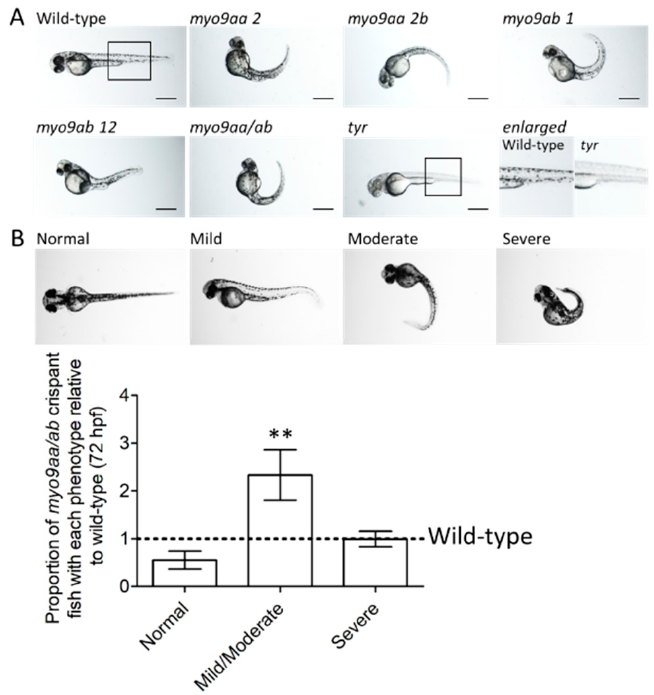
Figure 1. Phenotypes of myo9aa / ab crispant zebrafish. ( A ) Representative images of 48 hpf zebrafish injected with sgRNAs against myo9aa and myo9ab (numbers following the gene refer to exon targeted). Injection of a combination of all four sgRNAs was performed ( myo9aa / ab ), along with a control against the tyrosinase gene ( tyr ) in which no pigment can be observed, confirming knockdown success. Scale bar = 500 µ m. ( B ) Images showing phenotypic classification of injected zebrafish at 72 hours post fertilisation (hpf), ranging from normal to severe. Graph shows proportion of myo9aa / ab crispant fish injected with all four sgRNAs ( n = 7, including 160 fish in total) as compared to wild-types (black line, n = 7, including 138 fish in total). Error bars represent mean ± S.E.M, ** p < 0.01, paired t